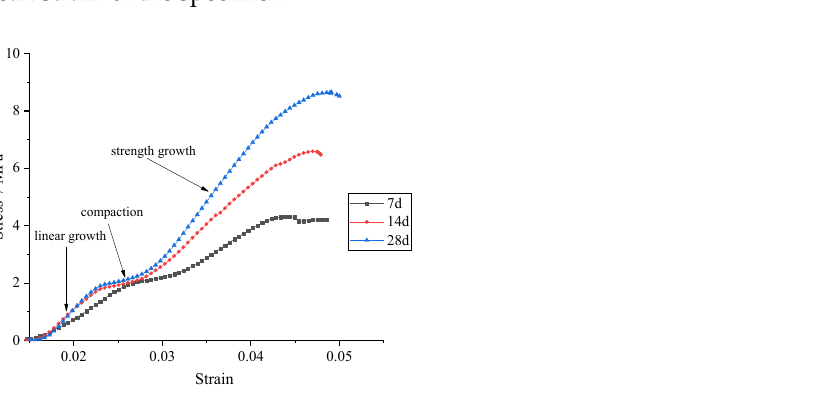
Figure 8. Stress–strain curves of specimens with 20% cement and 10% CFB-BA at different curing times.